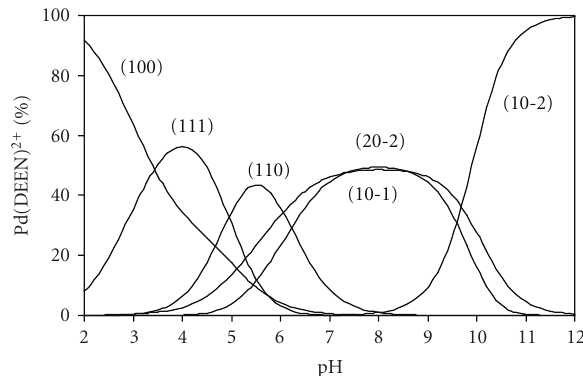
Figure 4: Concentration distribution diagram for various complex species in Pd(DEEN) 2+ -succinic acid